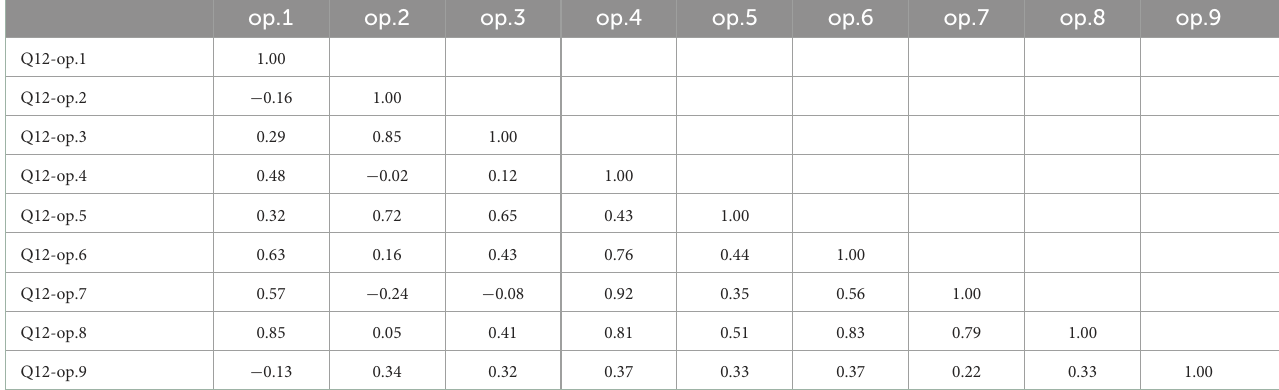
TABLE 3 Q12 “Students’ health and wellbeing risk factors self-evaluation,” correlation